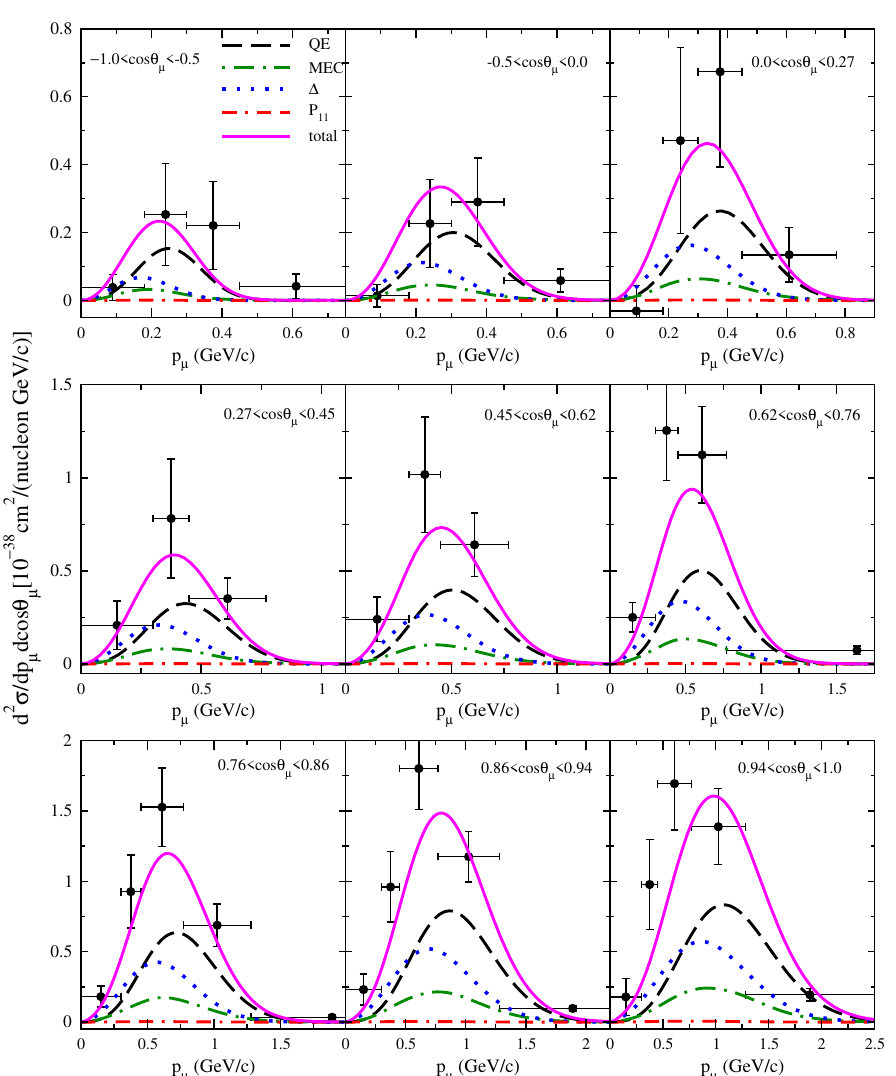
Figure 6. The SuSA inclusive double differential ( ν µ , µ − ) cross-section off 40 Ar, averaged over the MicroBooNE flux, is displayed, versus the muon momentum p µ . The separate QE, MEC, ∆ and P 11 contributions are shown. Data from Reference [53].